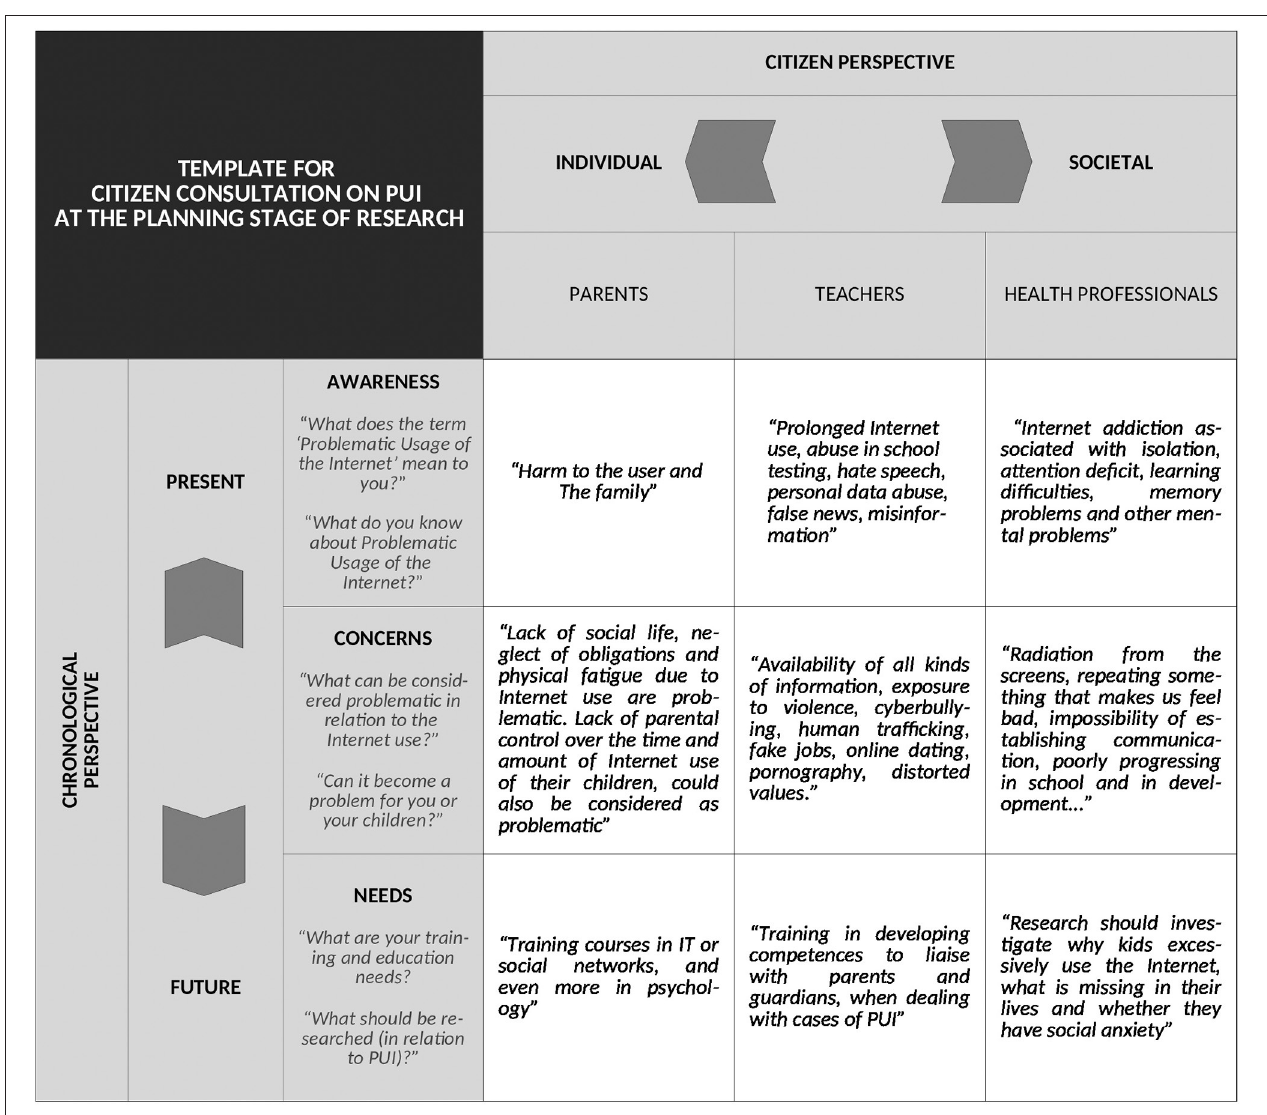
FIGURE 4 | The template illustrates the typical organization of an initial citizen consultation exercise on PUI. The vertical axis covers the chronological perspective, following the sequential order of addressed topics throughout the course of the exercise. The horizontal axis covers the individual perspective of interested groups of citizens. The first perspective expresses the present awareness, concerns and future needs of consulted citizens, while the second perspective describes their fixed opinions. The template also includes an illustrative list of the questions posed by the researchers, and a selection of sample quotes from some of the consulted